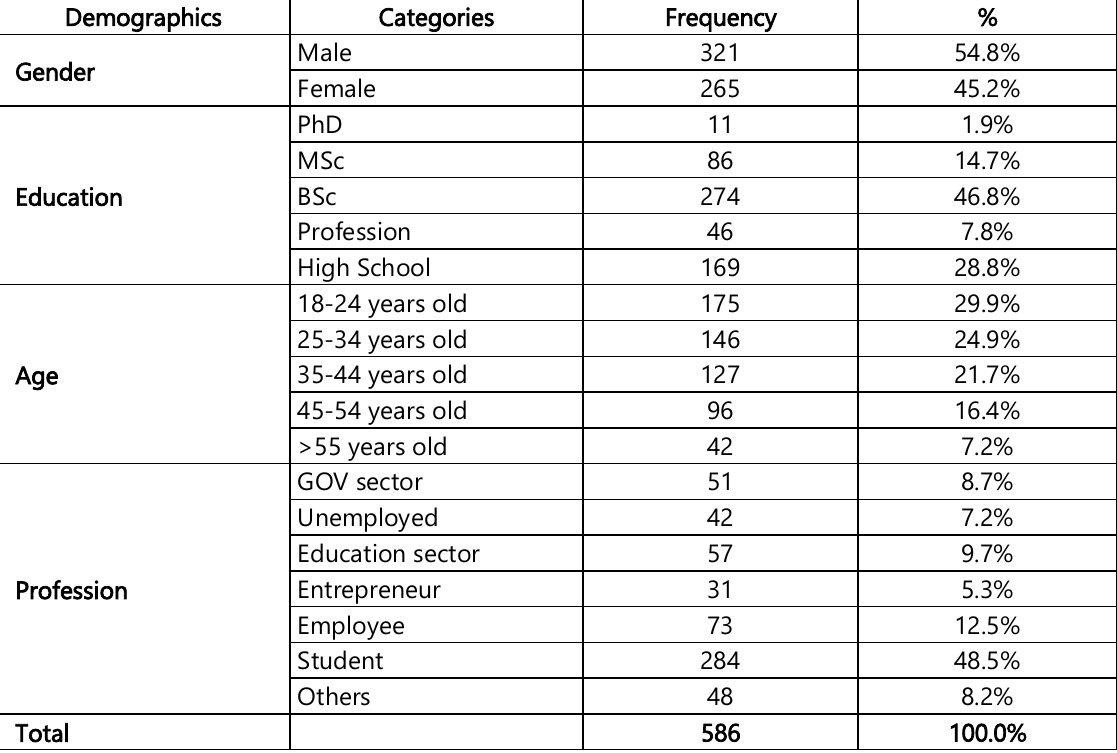
Table1: Demographic Data of Respondents (Source: Authors‟ depiction 2021) Demographics